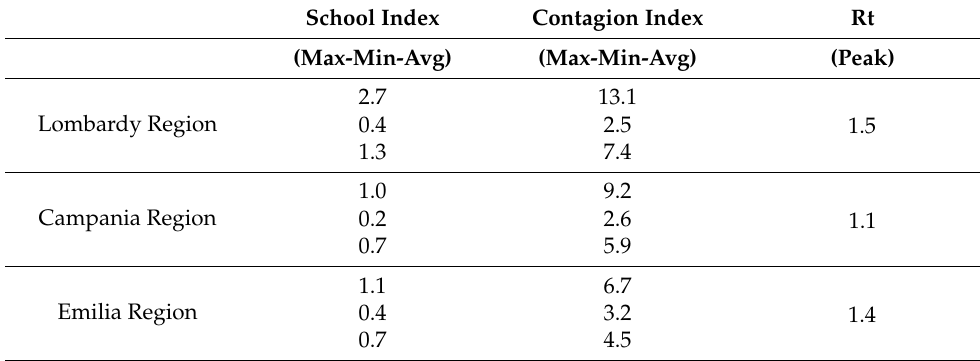
Table 3. Summary contagion